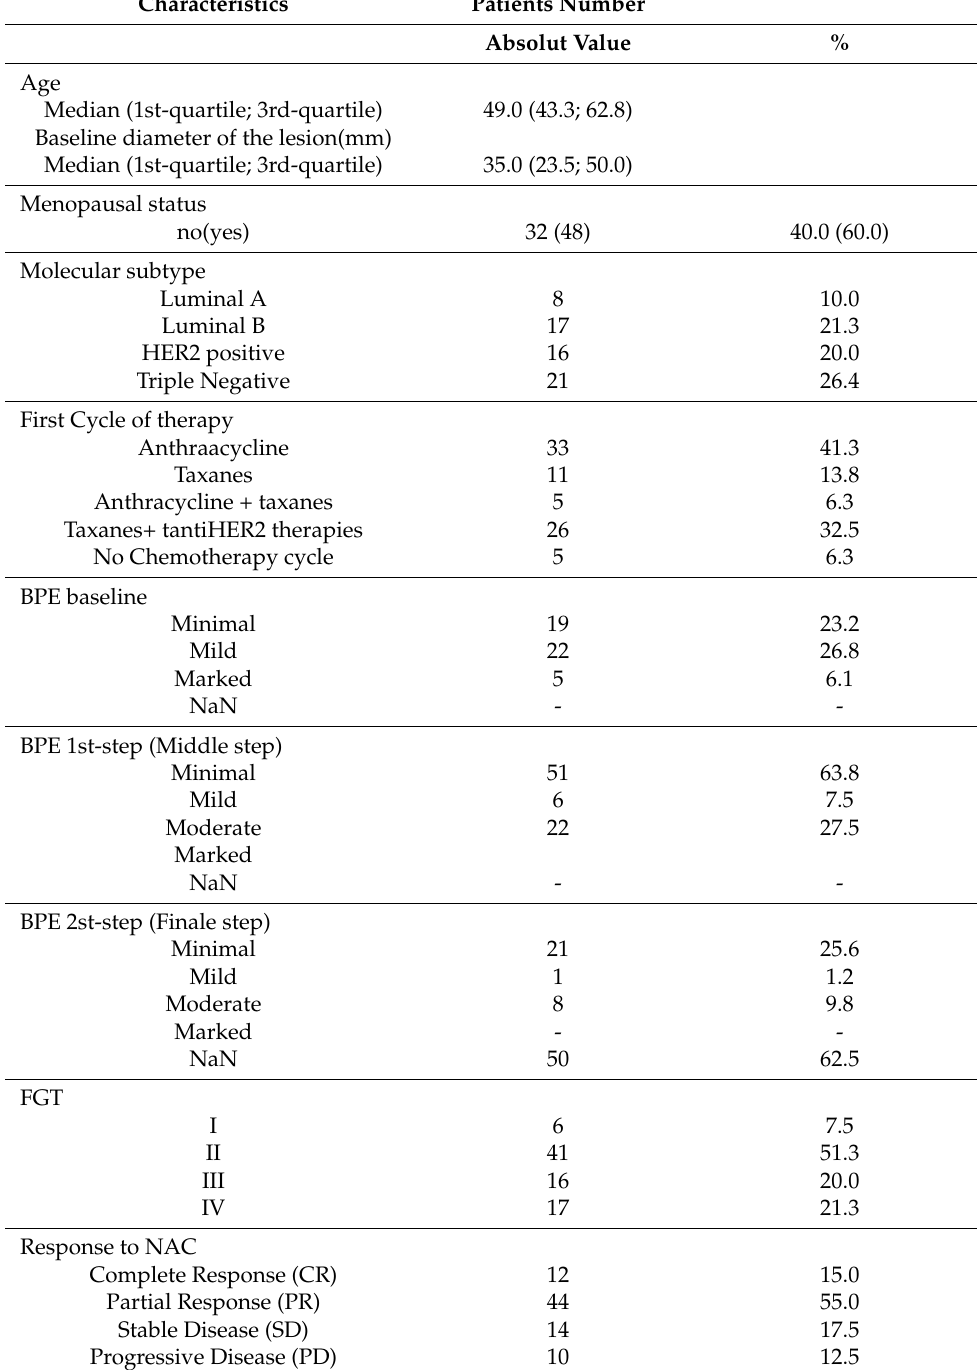
Table 1. Characteristics of the 80 patients analyzed in the study.